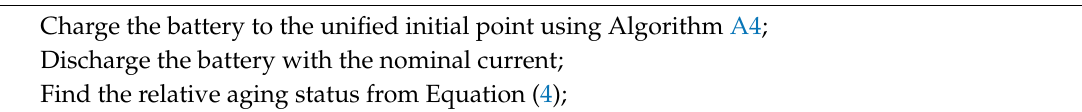
Algorithm A3: A general process to find the relative aging status of the